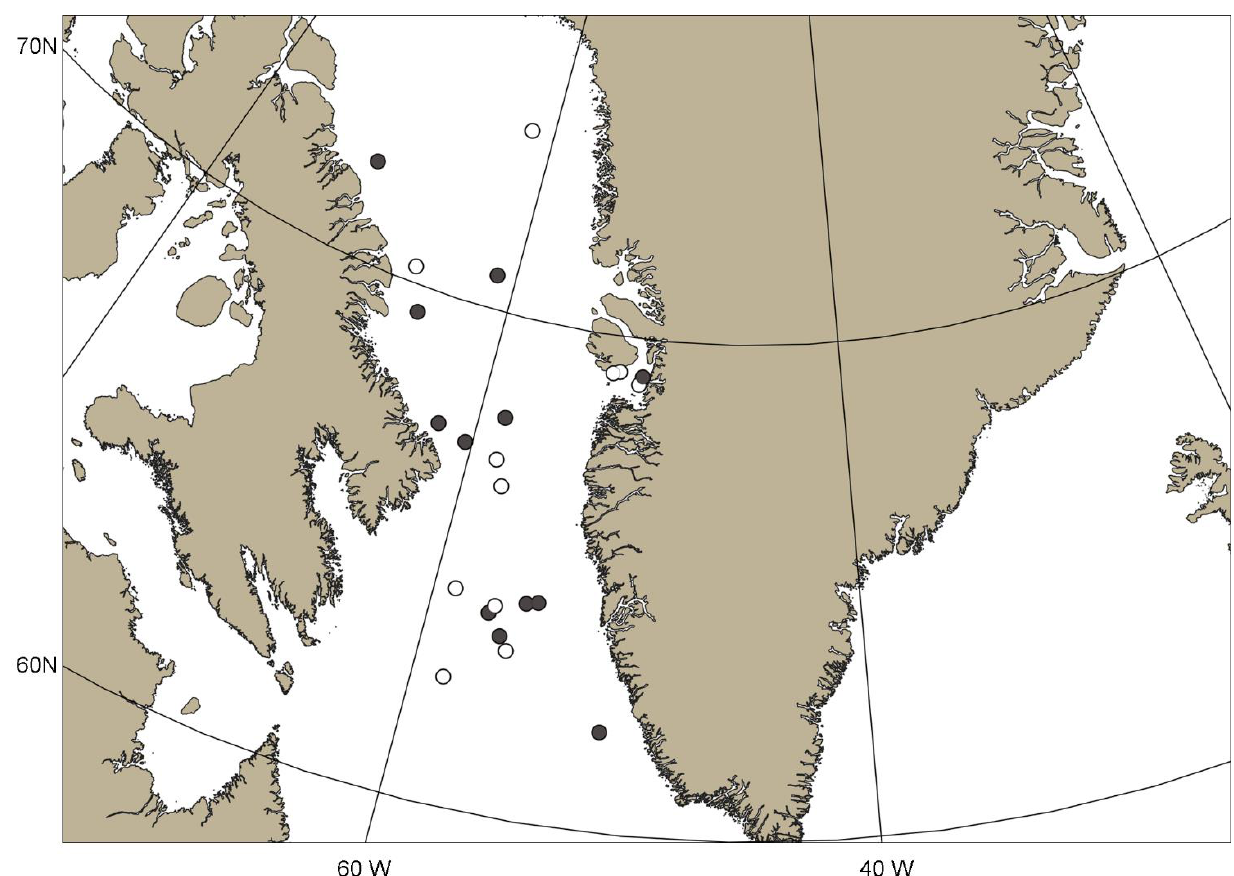
Figure 1. Sampling locations of Gonatus fabricii in West Greenland. Filled circles: stations where morphological beak measurements and stable isotope analysis were performed. Empty circles: stations where only morphological beak measurements were performed.